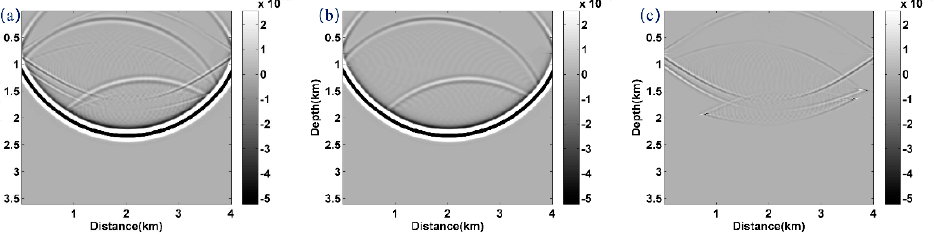
Figure 3. The 20th snapshots. ( a ) the coupled wavefield, ( b ) the decoupled P − component wavefield and ( c ) the decoupled S − component wavefield.